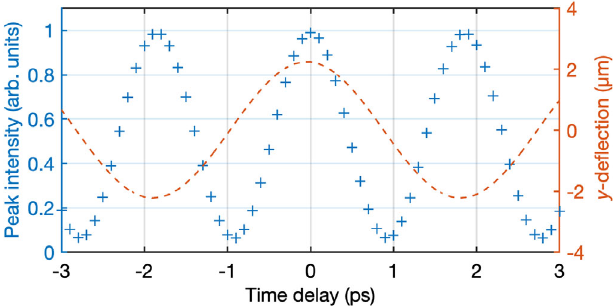
FIG. 4. Simulated on-axis peak intensity and total deflection in y -direction as a function of time delay between electron injection and